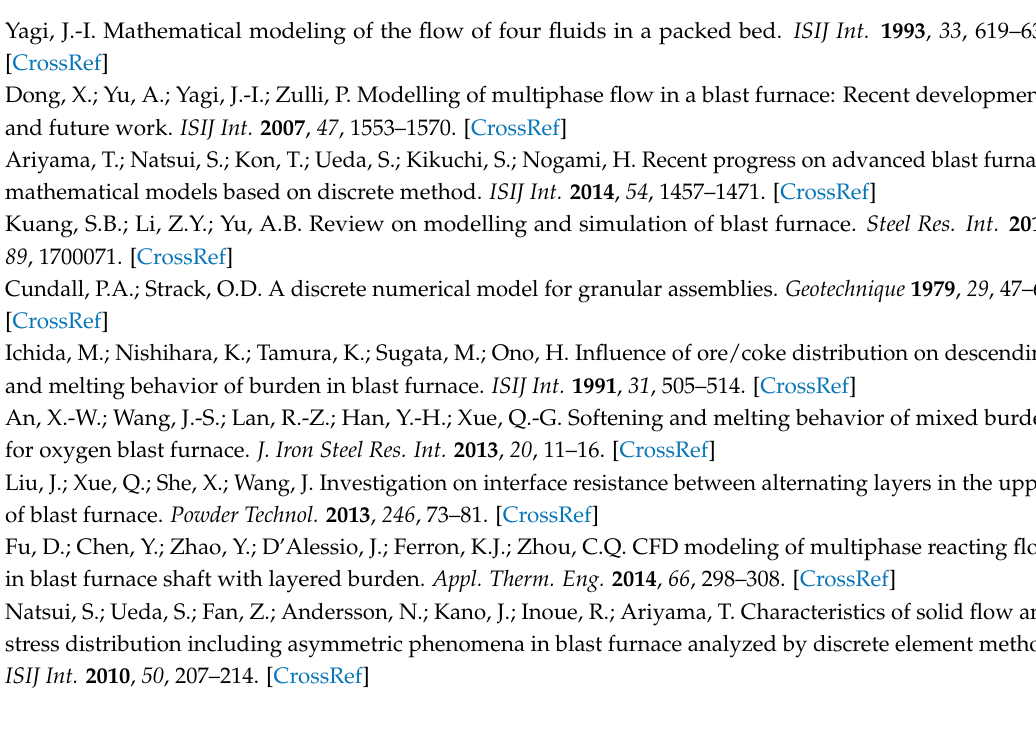
Figure A4. Features of the tracer line before and after the cutting method. ( a ) Tracer line on the flat wall; ( b ) tracer line on the section after the cutting method.